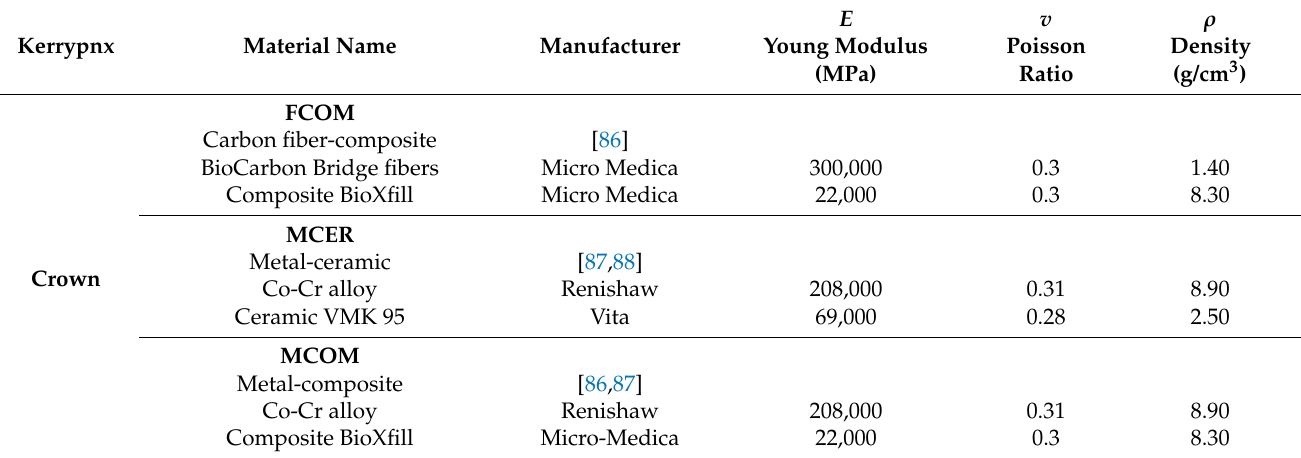
Table 1. Properties of materials used in the prothesis and the bone (trabecular and cortical).